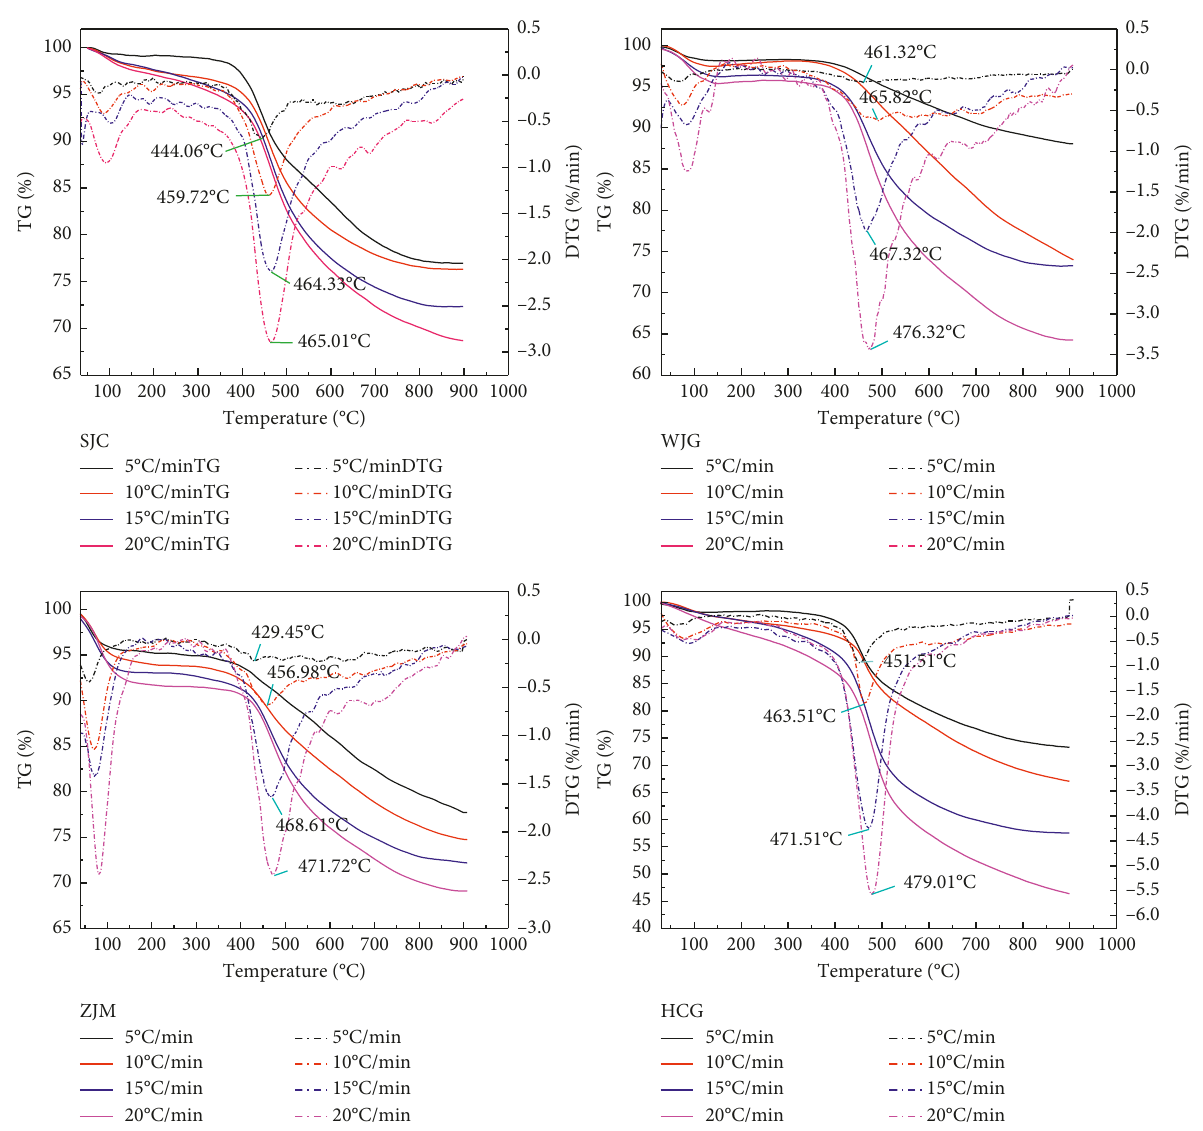
Figure 1: The curves of TG and